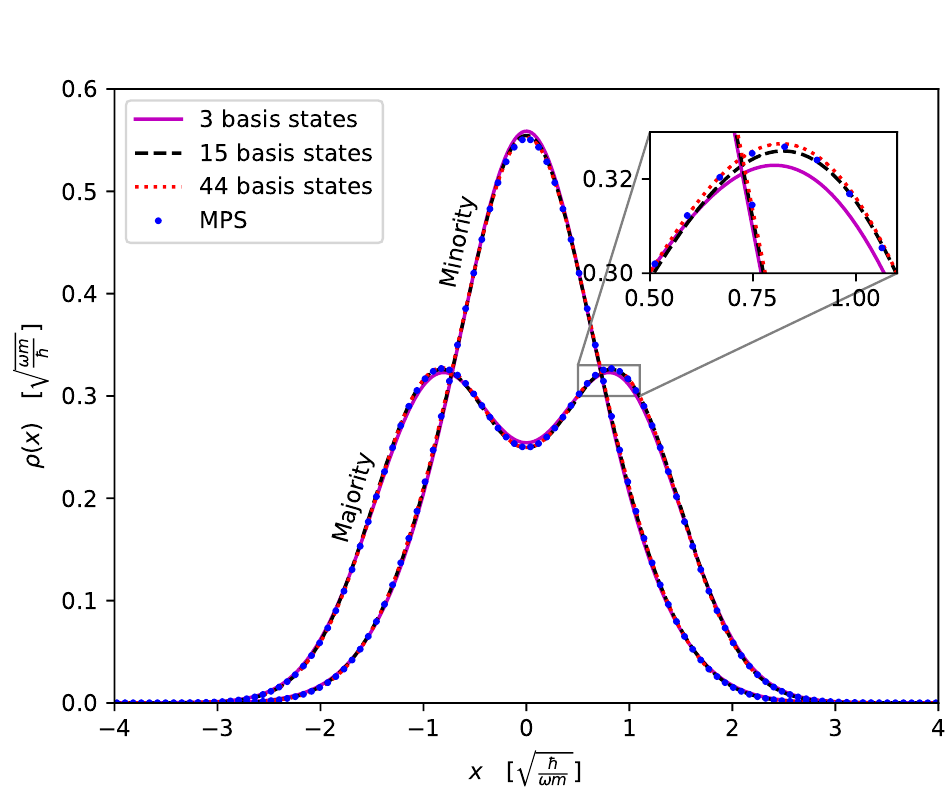
(cid:113) m = 1 for the 2 + 1 ħ h 3 ω